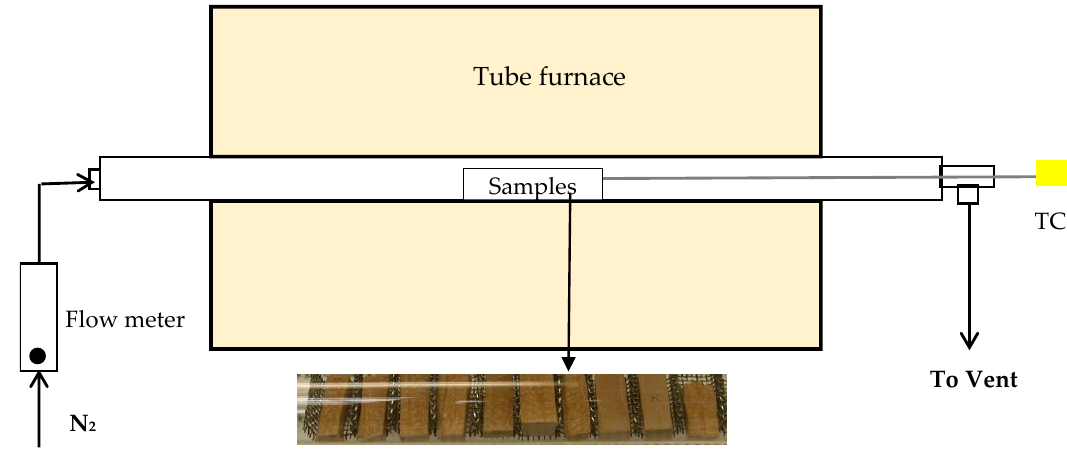
Figure 2. Schematic diagram of the thermal treatment experimental setup.